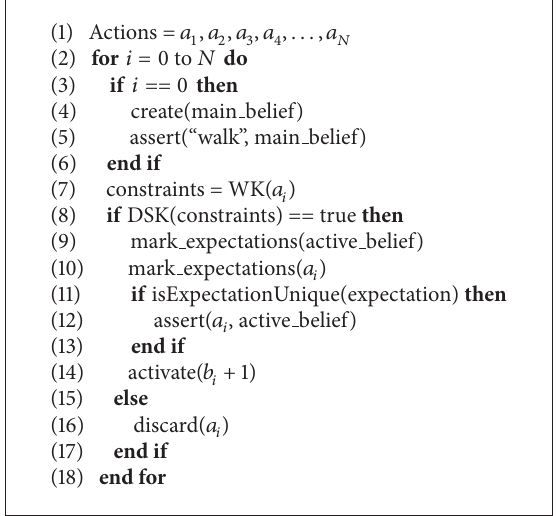
Algorithm 1: Perform estimation